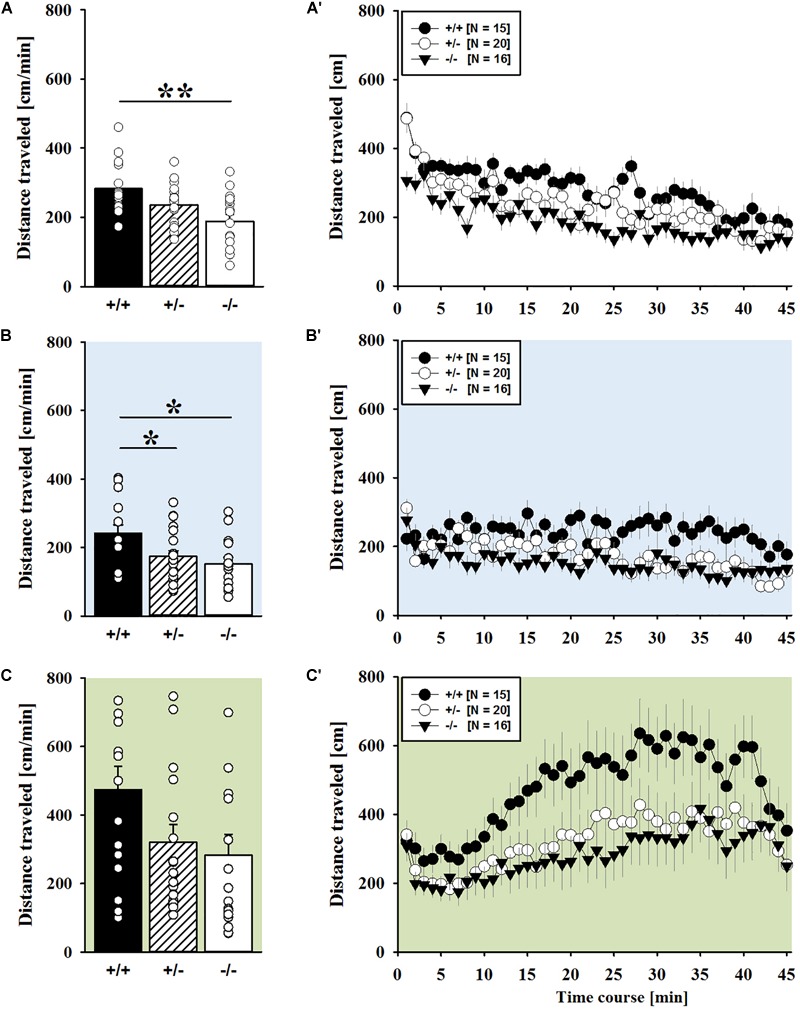
AMPH-induced hyperactivity in juvenile Shank1 mice. (A–C) Bar graphs and (A′–C′) line graphs depicting the distance traveled by Shank1+/+ (black bar/black circle), Shank1+/- (striped bar/white circle), and Shank1-/- (white bar/black triangle). Locomotor activity was compared during baseline testing (A,A′), following saline administration (B,B′), and after AMPH treatment (C,C′). Data are presented as means + SEM or means ± SEM. ∗p < 0.05, ∗∗p < 0.001.